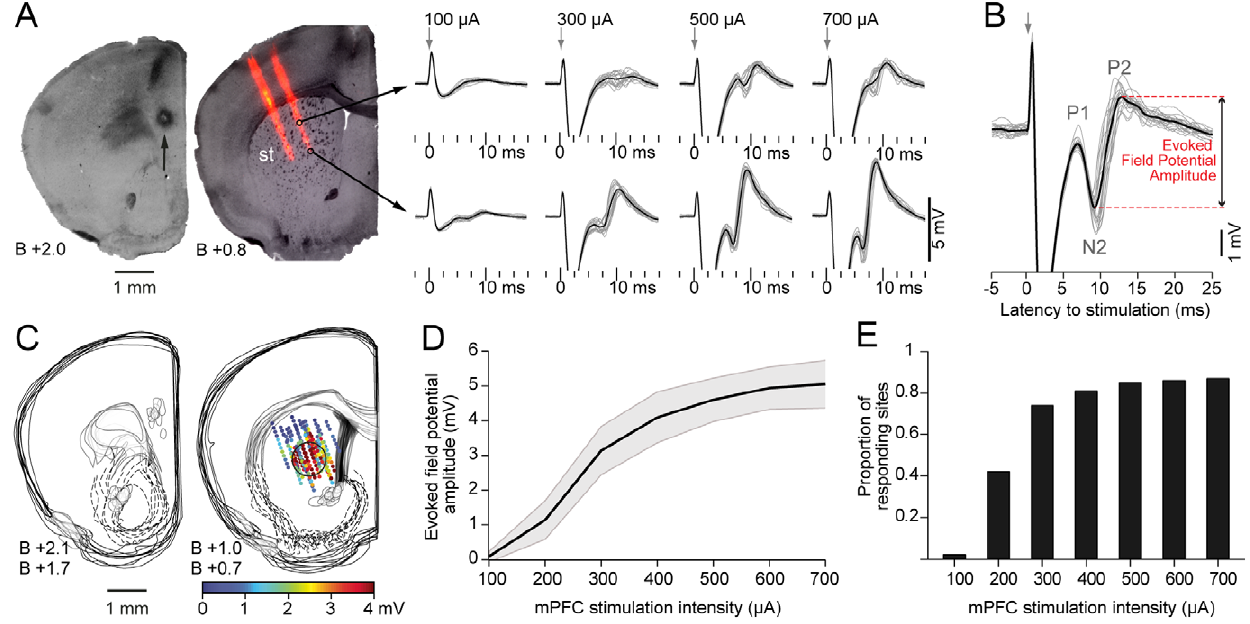
Figure 1. Evoked field potential amplitude changes along the dorsal striatum and with stimulation intensity. A. Representative histological sections showing the location of cortical (arrow, left ) stimulation electrode and striatal (st, right ) recording electrode. The striatal image was composed by overlaying microphotographs of the same section under transmitted light (tissue) and epifluorescence (electrode, red). Multichannel silicon probes were immersed in a DiI solution before electrophysiological experiments. Traces on the right are local field potentials evoked by stimulating the cortex with different current intensities (individual trials in gray, average in black). Note the higher amplitude of evoked responses at higher stimulation currents. B. Detail of a representative evoked field response. Field potential amplitude was measured between the N2 and P2 peak for each individual trial and then averaged. In these and all further traces positive is upward. Time 0 corresponds to cortical stimulation. C. Topographical reconstruction of stimulation sites ( left ) and striatal evoked responses ( right ) in 12 experiments. Focal stimulation (300 m A) at the prelimbic area produces a maximal response in a restricted region of the dorsal striatum conforming a ‘‘hot spot’’ (circle). D. Amplitude of the striatal field response at the hot spot as a function of stimulation current intensity (n=12 experiments, mean 6 SD). E. The number of striatal sites that respond to prelimbic cortex stimulation (evoked field potential amplitude higher than 0.3 mV) increases with stimulation intensity. However, many recording sites (38 out of 288 recorded sites) remained unresponsive even at 700 m